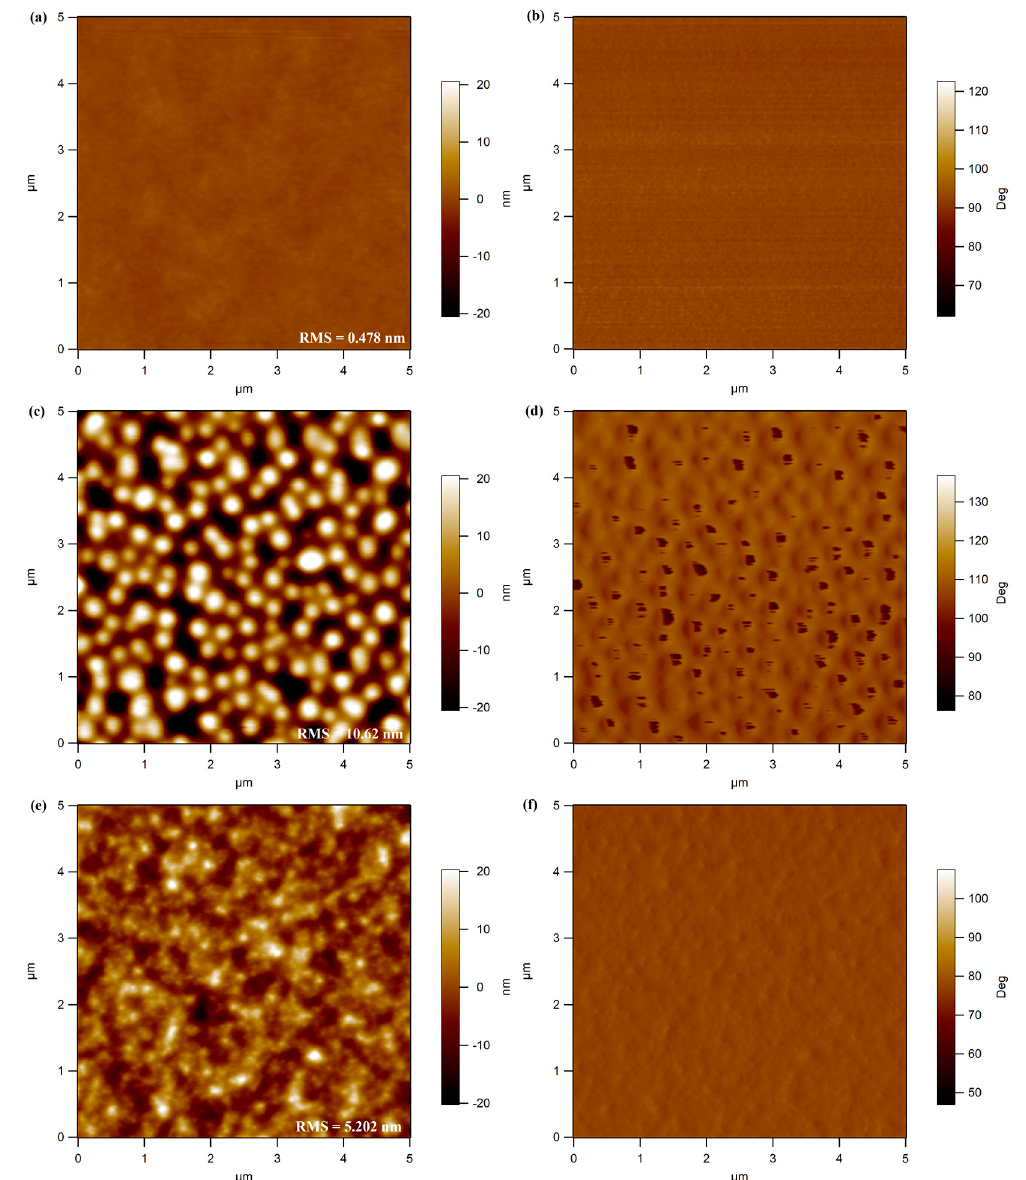
Figure 9. Tapping Atomic force microscopy (AFM) height ( left ) and phase ( right ) images of the active layers of PDTBDT-TIPS-DTBT-OD/PC 71 BM (1:1.5, 0%DIO, a , b ), PDTBDT-TIPS-DTFBT-OD/PC 61 BM (1:1.5, 0%DIO, c , d ) and PDTBDT-TIPS-DTNT-OD/PC 71 BM (1:1.5, 3%DIO, e , f ). Image size: 5 μ m × 5 μ m.